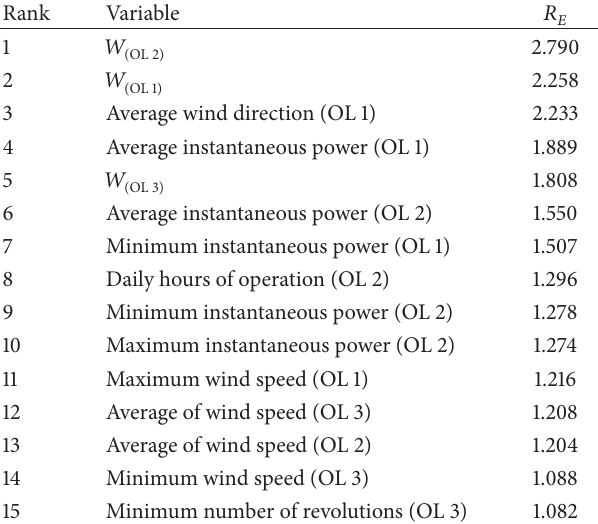
Table 14: Ranked error ratios for available input variables of the wind farm Olpe